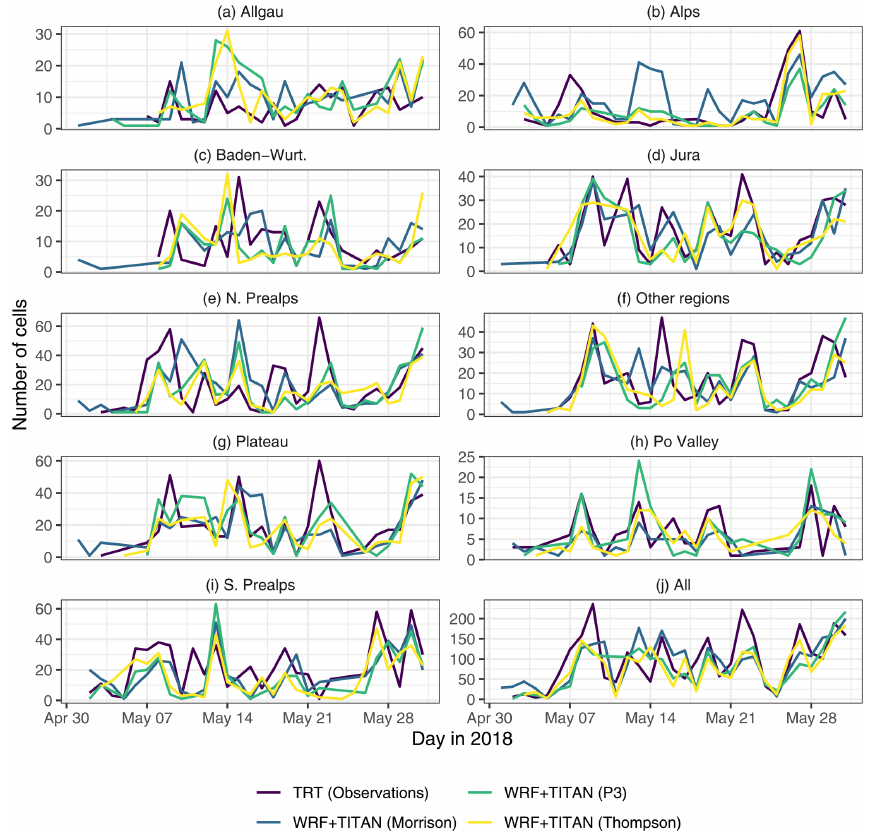
Figure 6. The number of cells detected per day in May 2018 for observations and simulated outputs per region (regions shown in Fig. 3).